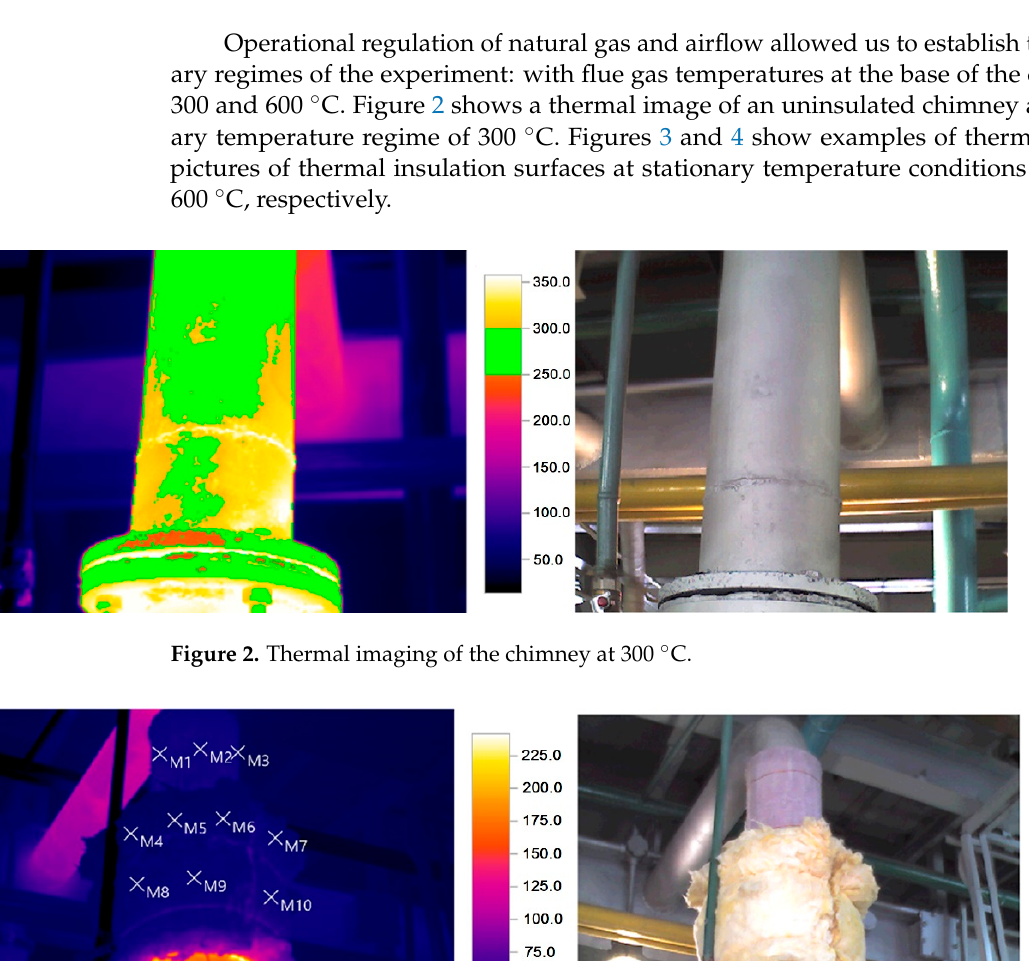
Figure 1. Natural gas furnace: ( a ) General view; ( b ) Chimney.